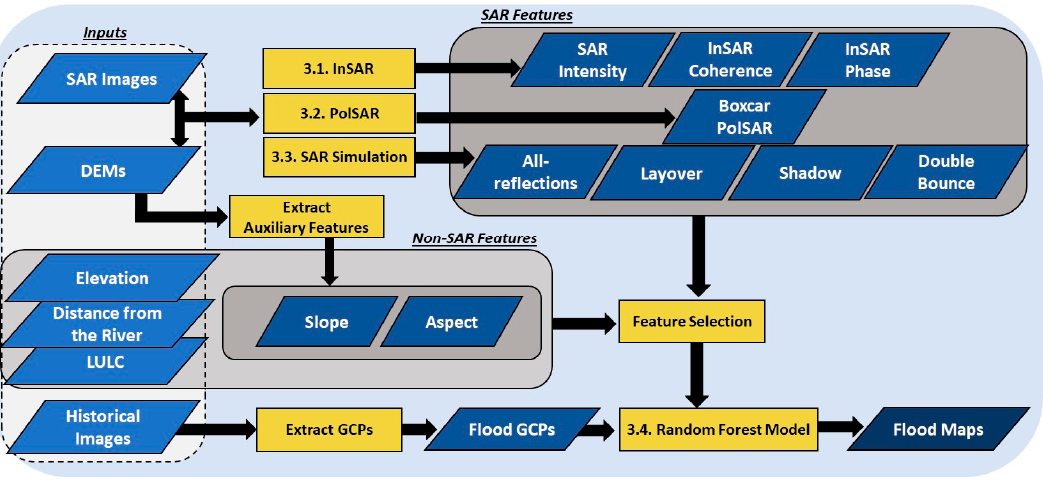
Figure 3. Research Method Framework.